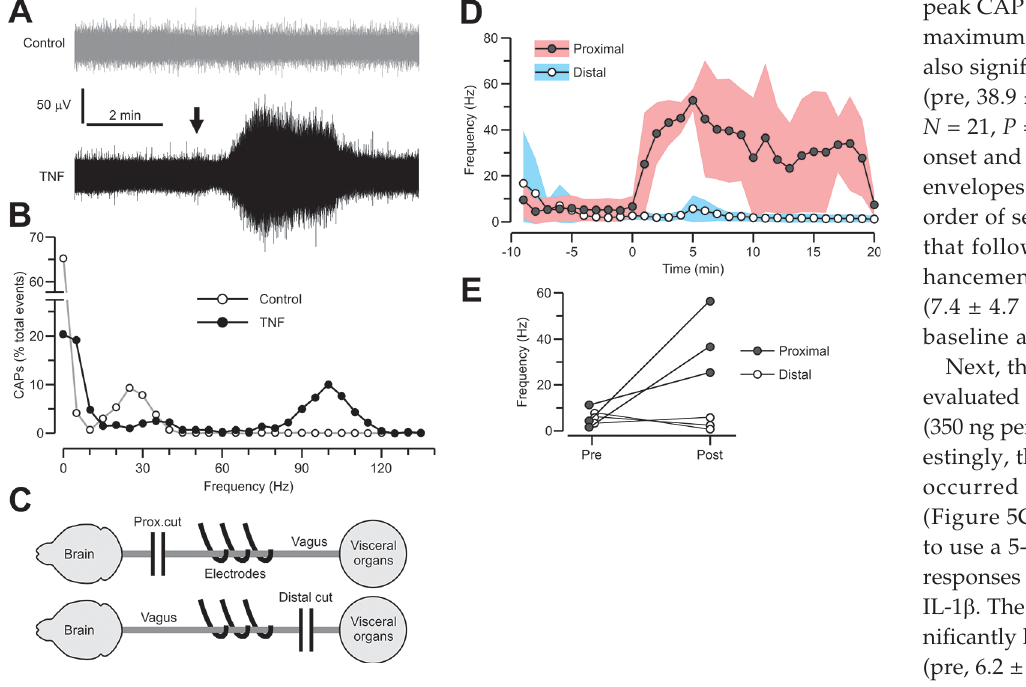
Figure 4. Afferent fibers of the vagus nerve carry TNF-induced neurograms. (A) (Top) Trace showing the spontaneous activity of the cervical vagus nerve. (Bottom) Trace showing the injection of TNF (dose of 50 μ g, marked by line). (B) Graph depicting the frequency of CAP firing for the control and TNF-induced neurograms (shown in A). The 10-min period immediately after TNF injection is used to calculate CAP firing, as well as the equivalent period from the baseline. (C) Diagrams of the surgical vagotomies employed to test the direction of flow of the TNF-induced neurogram. A proximal (Prox) cut between the electrodes and the brain isolates the sensory component, while a distal cut isolates the efferent arm. (D) Graph showing the frequency of CAP firing in 60-s bins (mean ± SEM, line ± shaded area) starting 10 min prior to TNF injection (dose of 50 μ g) at time zero. Data represent N = 3 for each of proximal (filled circles) and distal (open circles) vagot- omies. (E) Plot showing mean CAP frequencies for the 10-min periods before and right after TNF in individual mice. The distal cut completely abolishes the TNF effect, which is not affected by the proximal cut ( P = .03 for post values, t test), indicating that afferent fibers are